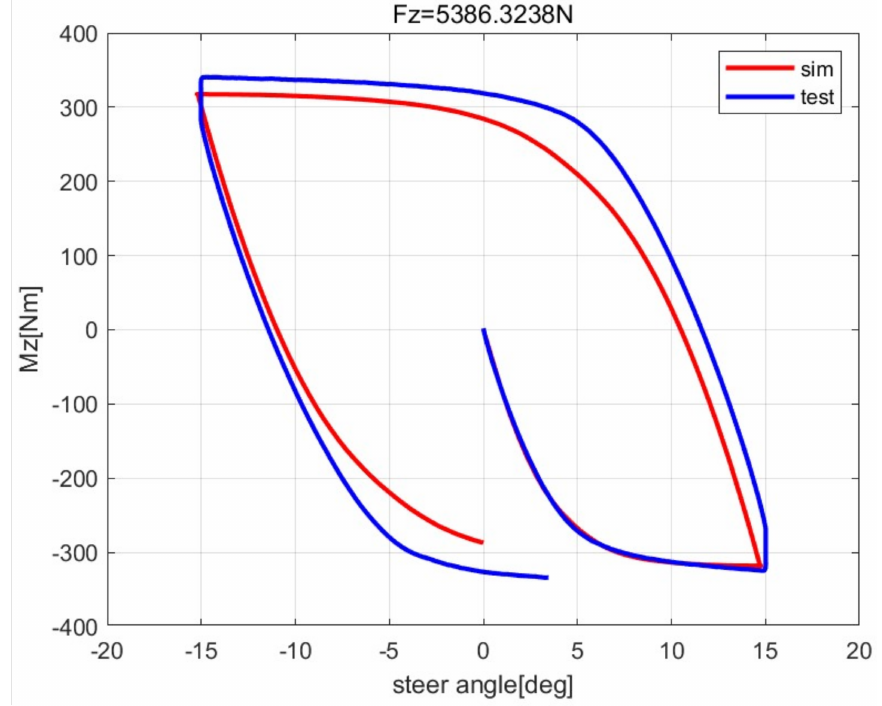
Figure 9. Parking comparison between model and test.